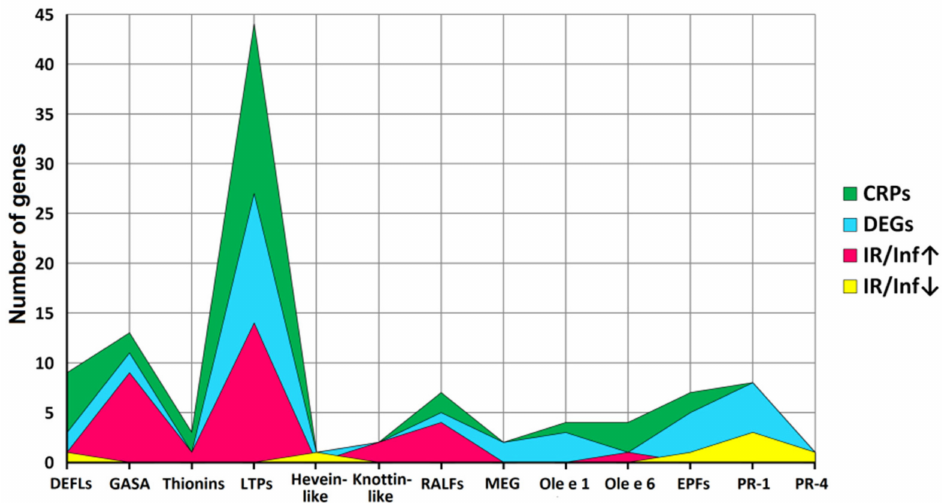
Figure 4. Family distribution of CRP genes, differentially expressed genes (DEGs), and genes up-regulated (IR/Inf ↑ ) and down-regulated (IR/Inf ↓ ) in IR-displaying plants compared to infected at 4